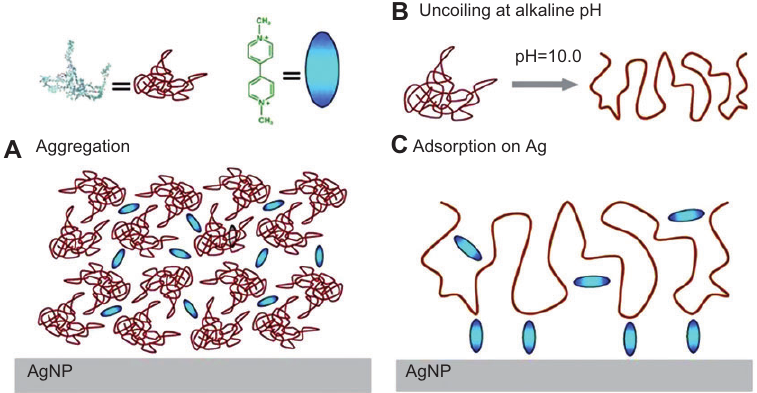
Figure 7 Illustration of the dependence of humic acid conformation on acidic and alkaline pH, and the adsorption processes of humic acid and paraquat onto the Ag surface. Reproduced with permission from: Roldan et al. (2011) . Copyright 2011,